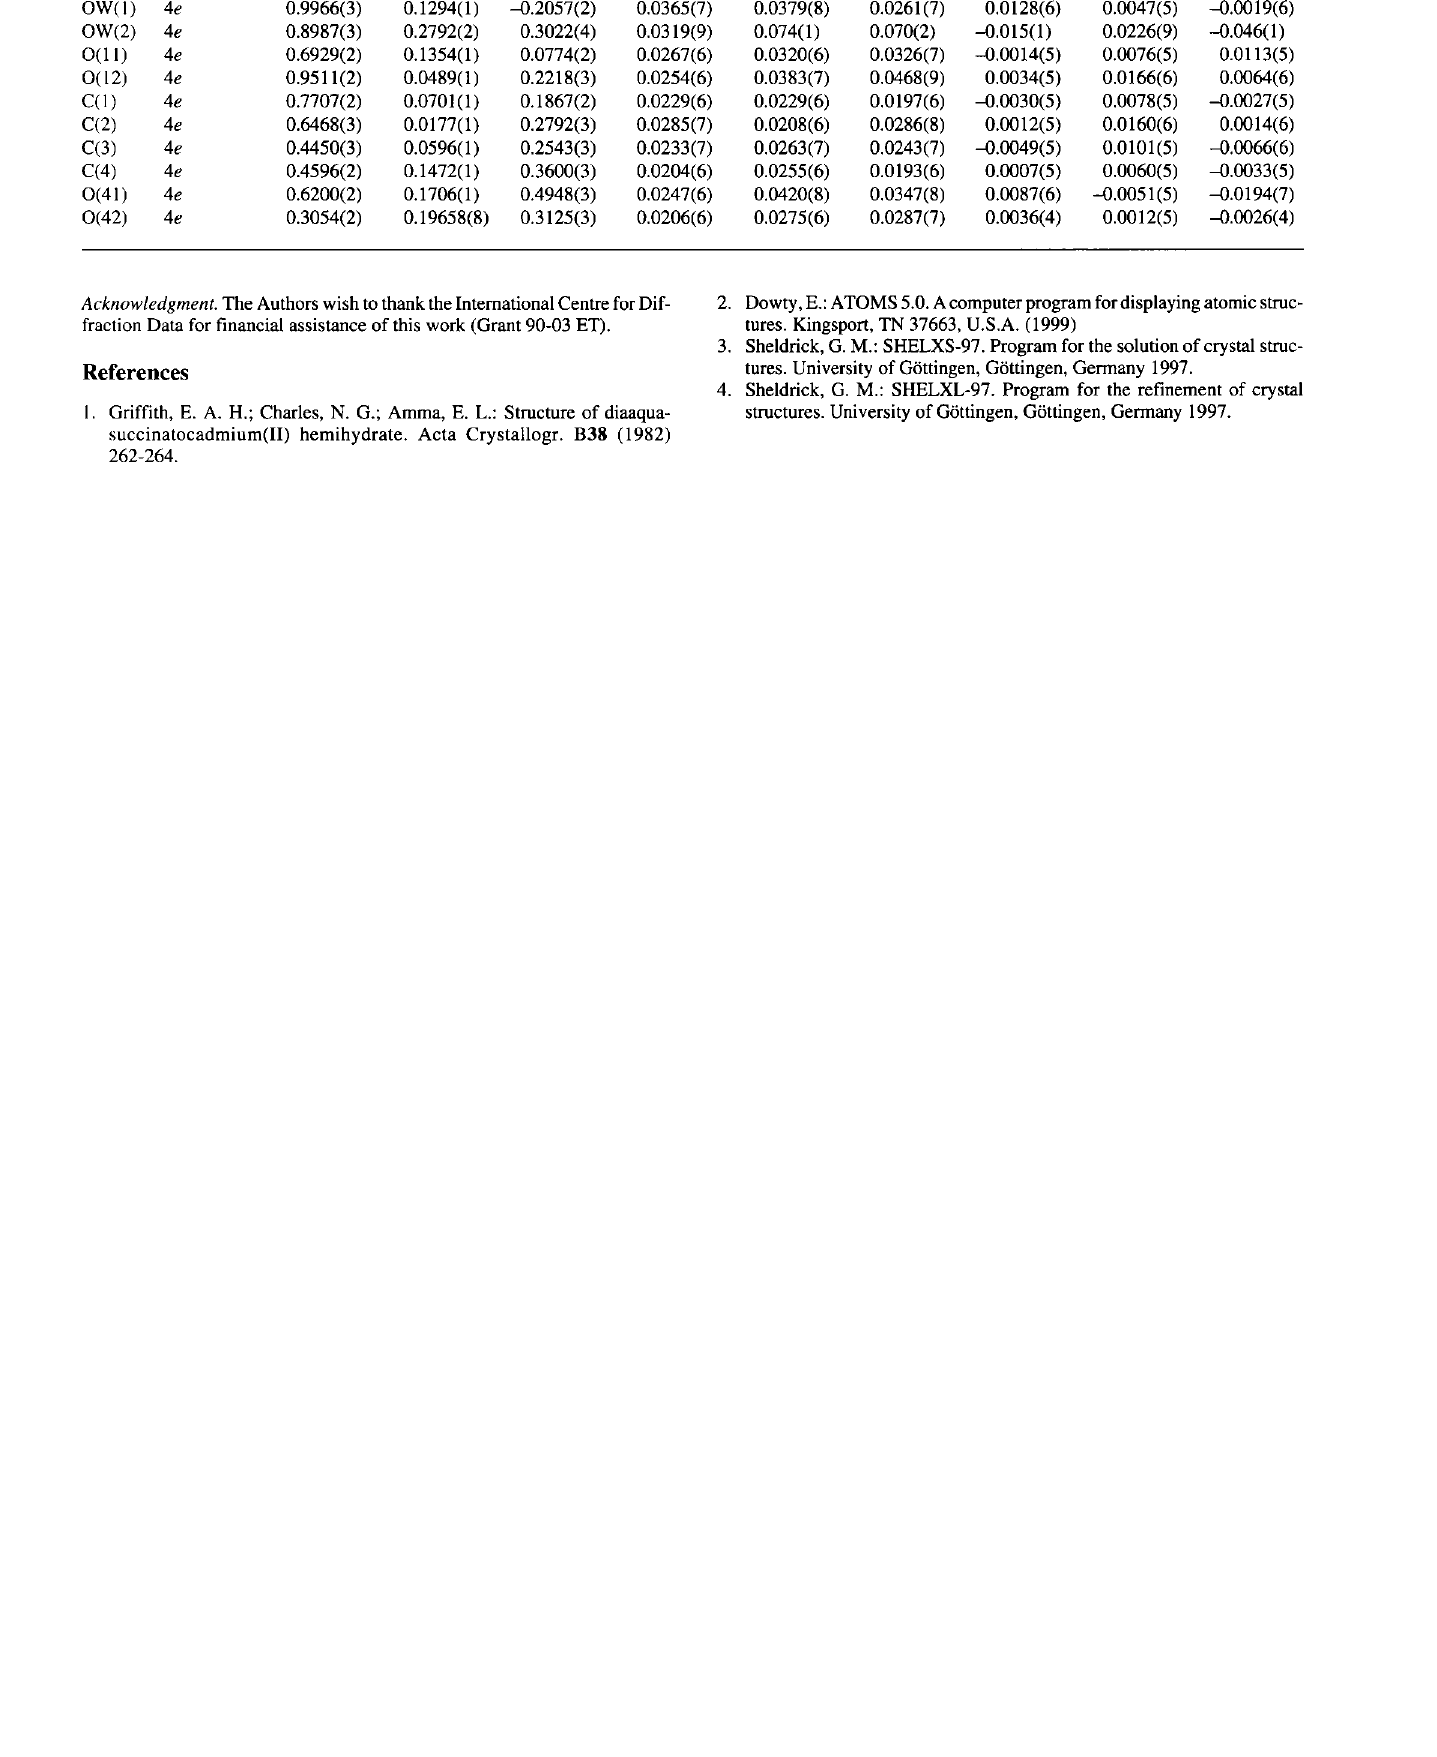
Table 3. Atomic coordinates and displacement parameters (in Â 2